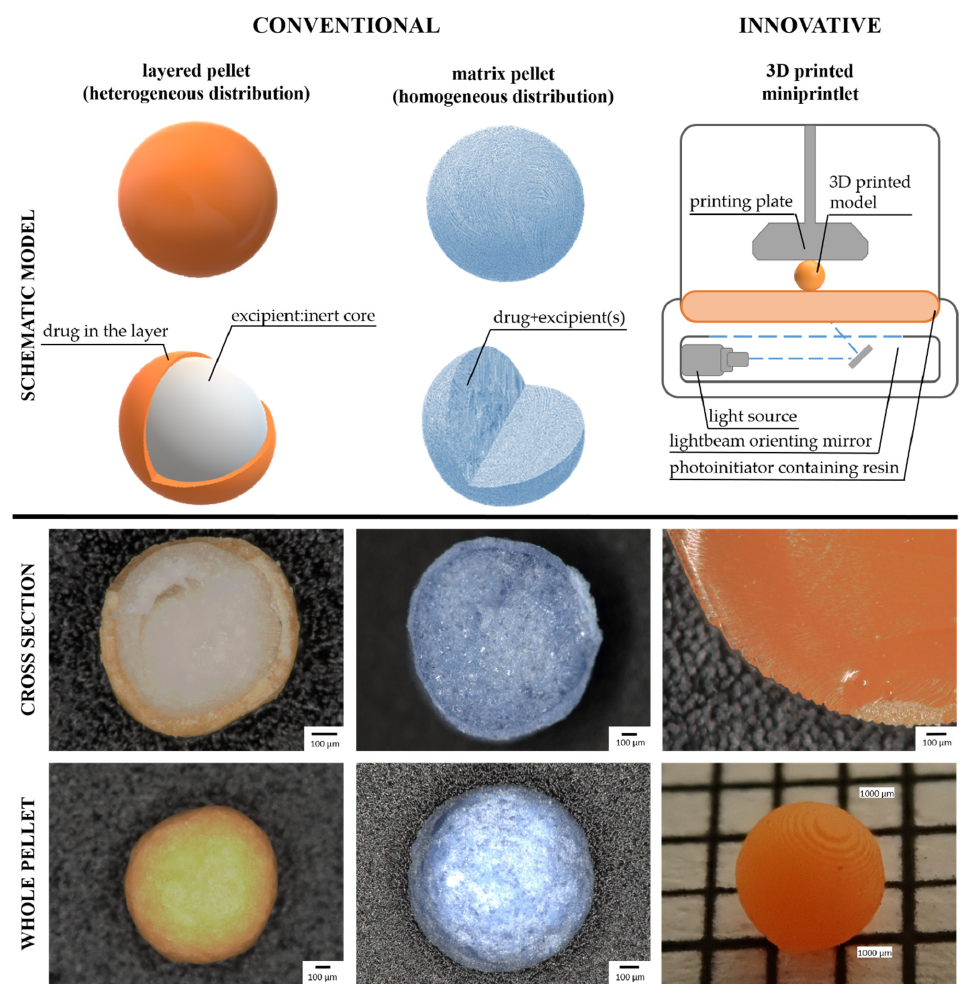
Figure 1. Pellets prepared by conventional and innovative technologies (Photos: Keyence VHX 970 digital microscope, Olympus Stylus TG-4 digital camera; 3D printer: Original Prusa SL1S SPEED 3D printer).